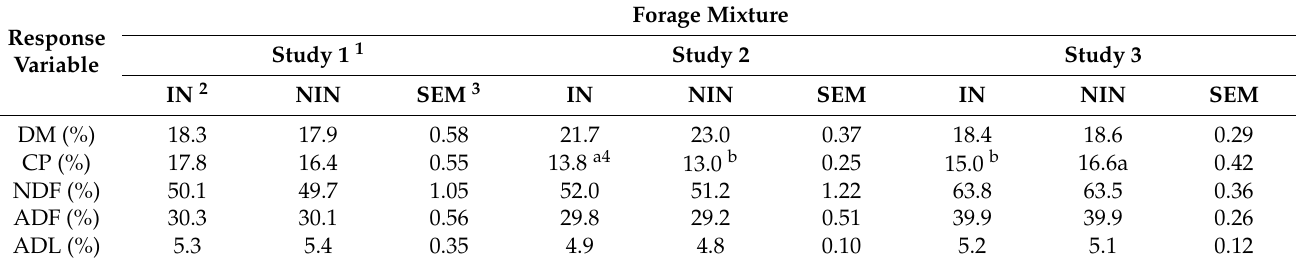
Table 2. Dry matter (DM), crude protein (CP), neutral detergent fiber (NDF), acid detergent fiber (ADF), and lignin concentrations under two inoculant